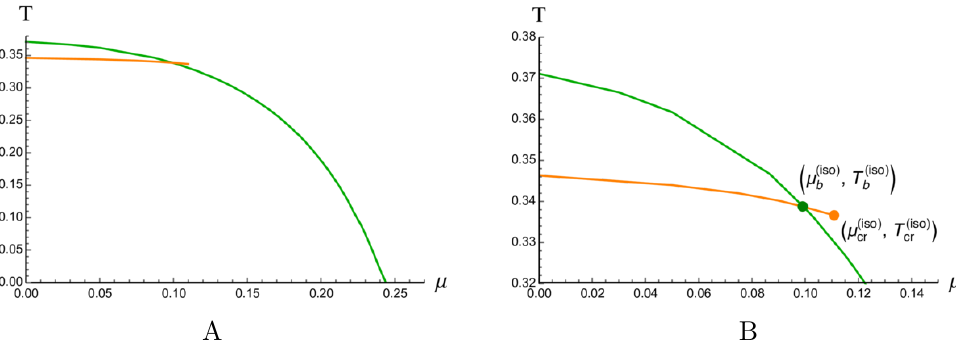
A B Figure 42 . Con(cid:12)nement-decon(cid:12)nement phase transition in the isotropic case, (cid:23) = 1, c = (cid:0) 1 for the Wilson line W iso (green) and the background (orange) (A). Plot (B) is a zoom of (A) near the intersection point ( (cid:22) (iso) ; T (iso) ) and critical point ( (cid:22) (iso) cr ; T (iso) cr b b